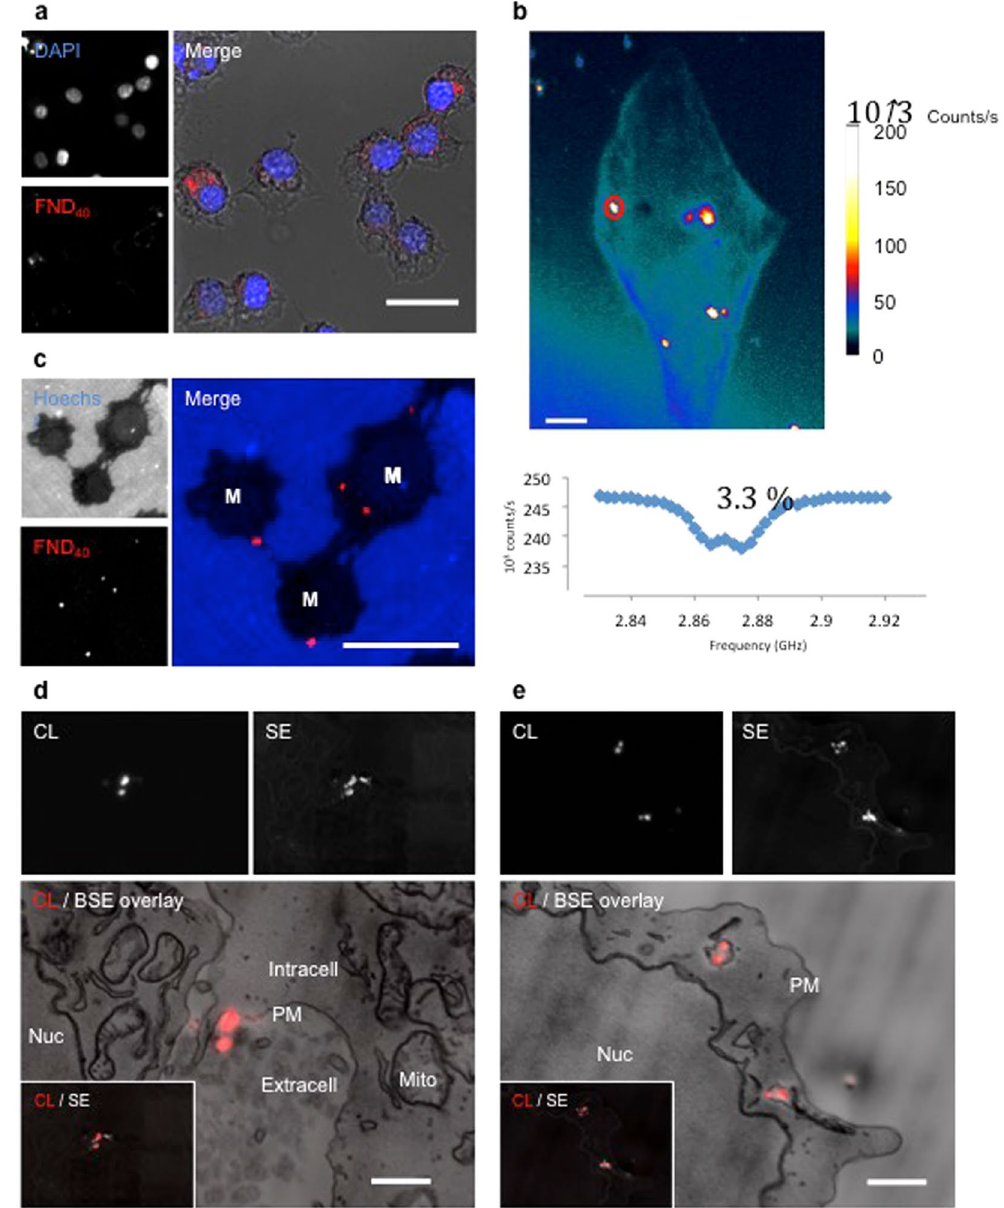
Figure 3. FND40 uptake by macrophages assessed by fluorescence microscopy, EM, magnetic resonance and CL. ( a ) Pre-embedding fluorescence of FND40 internalized by macrophages as seen in the diffraction interference contrast (DIC) merged picture. Nuclei are counterstained with DAPI. ( b ) Magnetic resonance spectra where taken at the bright spots identified as diamonds. The graph shows the spectrum taken at the red circle. 3,3% is the contrast between the resonance line and the background for 1 run. ( c ) Fluorescence from FND40 in a 300 nm semi-thin epon section from macrophages (M). Nuclei are counterstained with Hoechst; blue outside the cells is autofluorescence caused by epon. ( d , e ) CL, SE and the CL overlaid with BSE images of FND40 particles. ( d ) extracellular of the plasma membrane during engulfing. The lower left corner shows an overlay of CL and SE of the same image. Some particles are clearly observed with SE and not with CL. ( e ) FND40 particles internalized by the macrophage as they are inside vesicles. The lower left corner shows an overlay of CL and SE of the same image. Some particles are observed with SE and not with CL, but also particles observed with CL are not visible with SE. Note that single FND40 particles within one vesicle can be resolved by CL. M: macrophage; Nuc: nucleus; Intra: intracellular; Extra: extracellular; PM: plasma membrane; Mito: mitochondria; CL: cathodoluminescence; SE: secondary electrons; BSE: Backscattered electrons. Bars: ( a